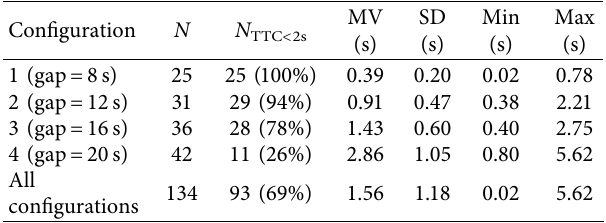
Table 5: Number of measurements, mean value, and standard deviation of TTC in each analysis